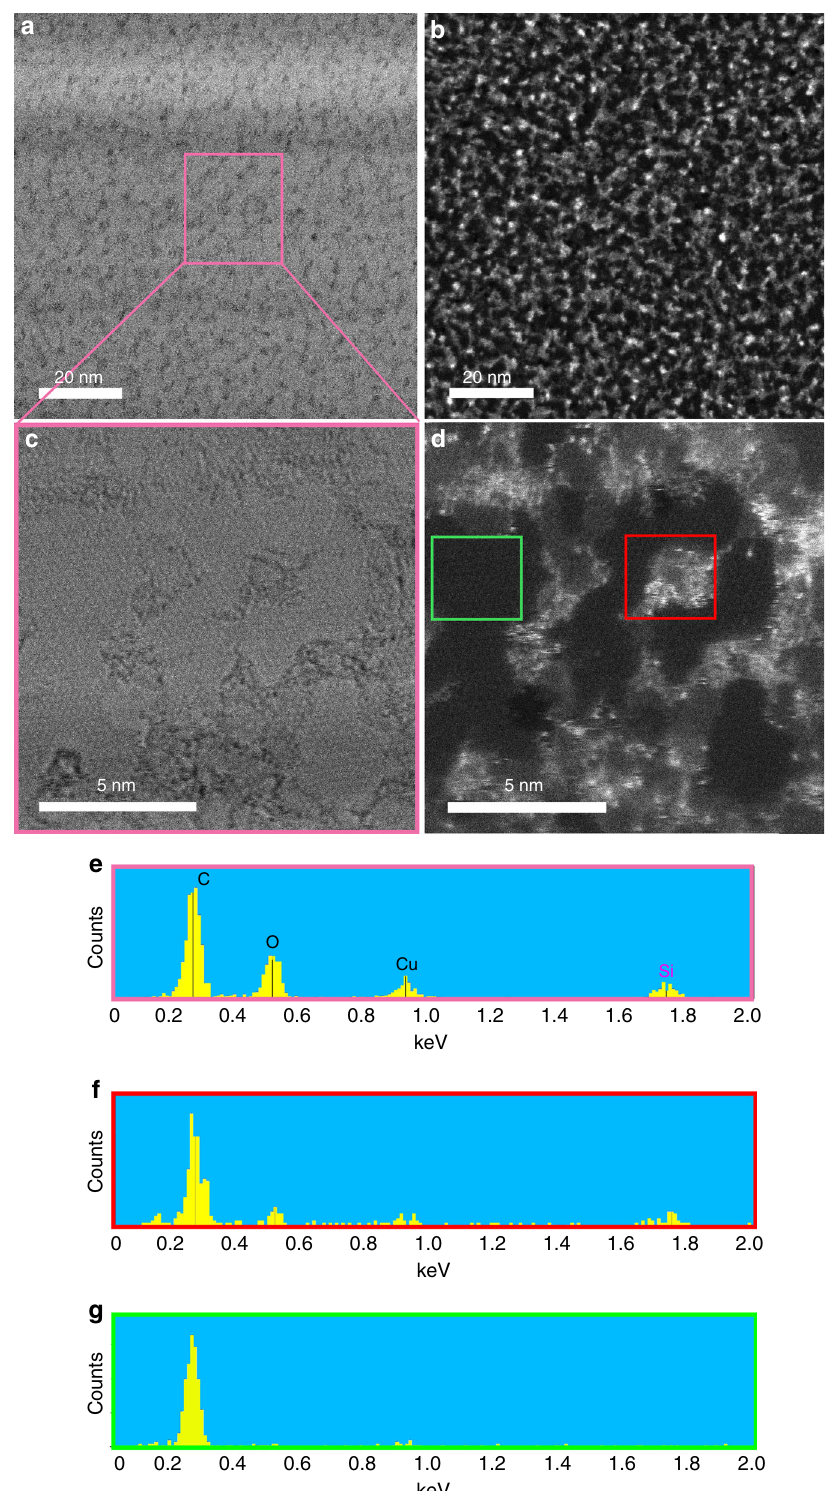
Fig. 2 The extent of silicon-based contamination on the surface of typical graphene oxide derived from low-purity graphite (98% purity). a Bright- fi eld (BF) image of a typical GO sheet. b HAADF image of a . c , d Details of BF and HAADF images of the marked region in a at higher magni fi cation, respectively. Unlike the BF images in which Si contaminants are largely invisible, the HAADF images highlights them as bright clusters. e EDS spectrum of the entire region shown as pink box in a , c . The strong Si peak at 1.739 keV con fi rms the signi fi cant contamination in the GO sample. f , g A comparison of the EDS spectra of the contaminated area ( f ) and non-contaminated area ( g ), which are marked as red and green boxes in d ,